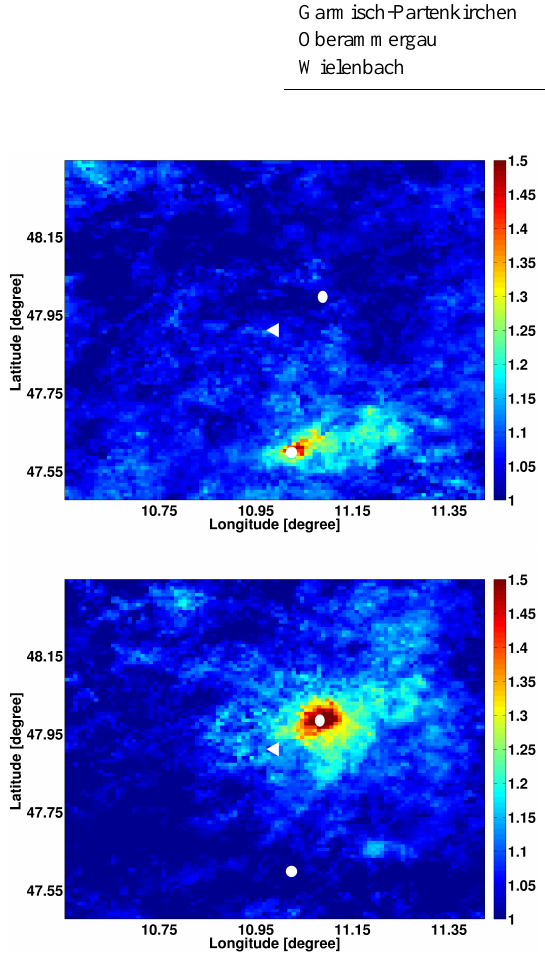
Fig. 9: Precipitation field [mm/h] in the data space derived with the Maximum Theta method for 14/07/2008 (13:00).